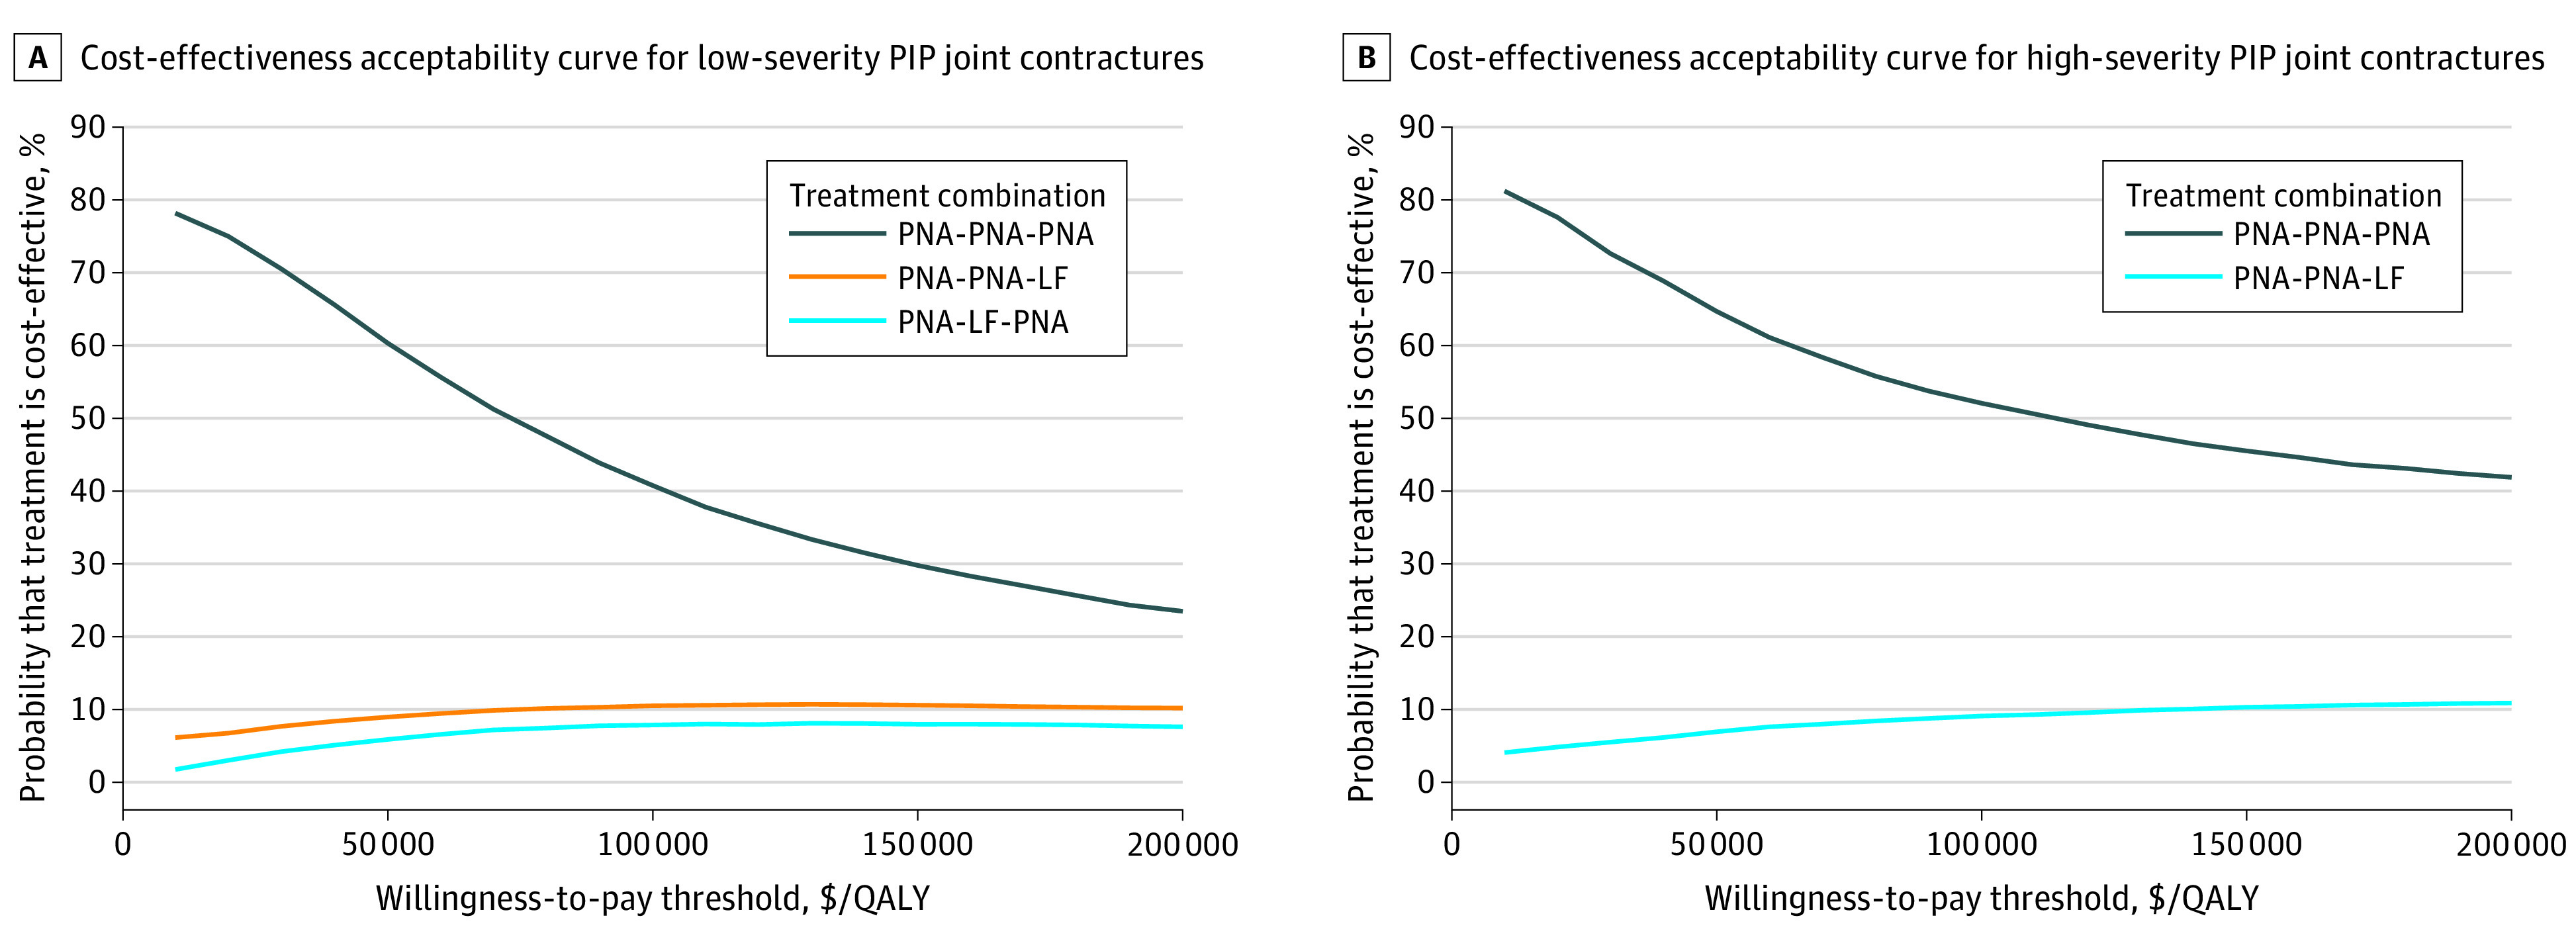
Cost-effectiveness Acceptability Curve for Proximal Interphalangeal (PIP) Joint ContracturesAt a willingness-to-pay threshold of $100 000 per quality-adjusted life-year (QALY), 3 percutaneous needle aponeurotomy (PNA) treatments (PNA-PNA-PNA) had a 41% and 52% chance of being the most cost-effective treatment combination compared with the remaining 26 treatment sequences in low-severity and high-severity MCP joint contractures, respectively. LF indicates limited fasciectomy.